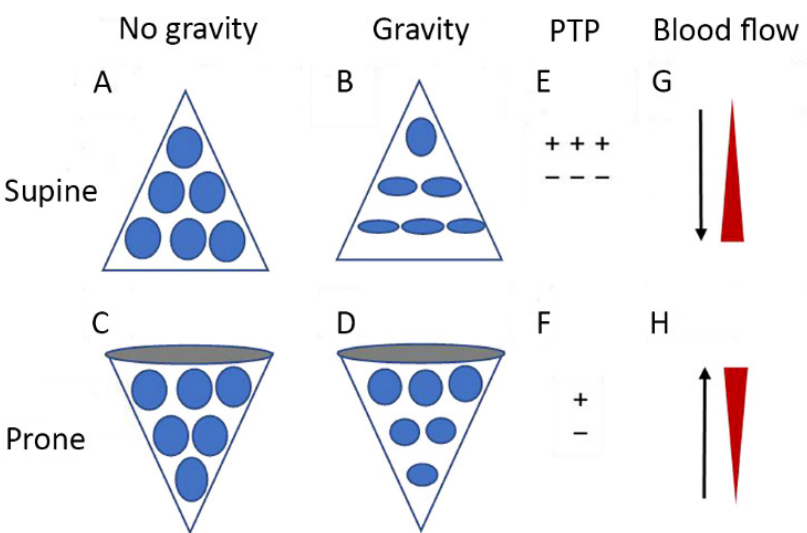
Figure 2. Diagrammatic presentation of physiological mechanisms associated with pronation in acute respiratory distress syndrome (ARDS). ( A , C ) show the shape of lung units (i.e., alveoli) without the effect of gravity. ( B ) In the supine position, the volume of dorsal lung units is significantly smaller than the volume of ventral lung units, as a result of gravity and pleural pressure; thus, ventral lung units are more prone to overdistention and dorsal lung units are more prone to compression atelectasis. ( D ) In the prone position, gravity and pleural pressure result in a decrease in the volume of the ventral lung units and an increase in the volume of the dorsal lung units. ( E ) In the supine position, the ventral transpulmonary pressure (PTP) may substantially exceed the dorsal PTP ( F ) Prone positioning reduces the ventral-to-dorsal PTP gradient thereby augmenting the homogeneity of ventilation. ( G ) The reopening, dorsal lung units continue to receive most of the blood flow. ( H ) The ventral lung units may exhibit a greater tendency to collapse, but are still relatively underperfused. Reproduced in concordance with the Creative Commons Attribution License (CC-BY) from